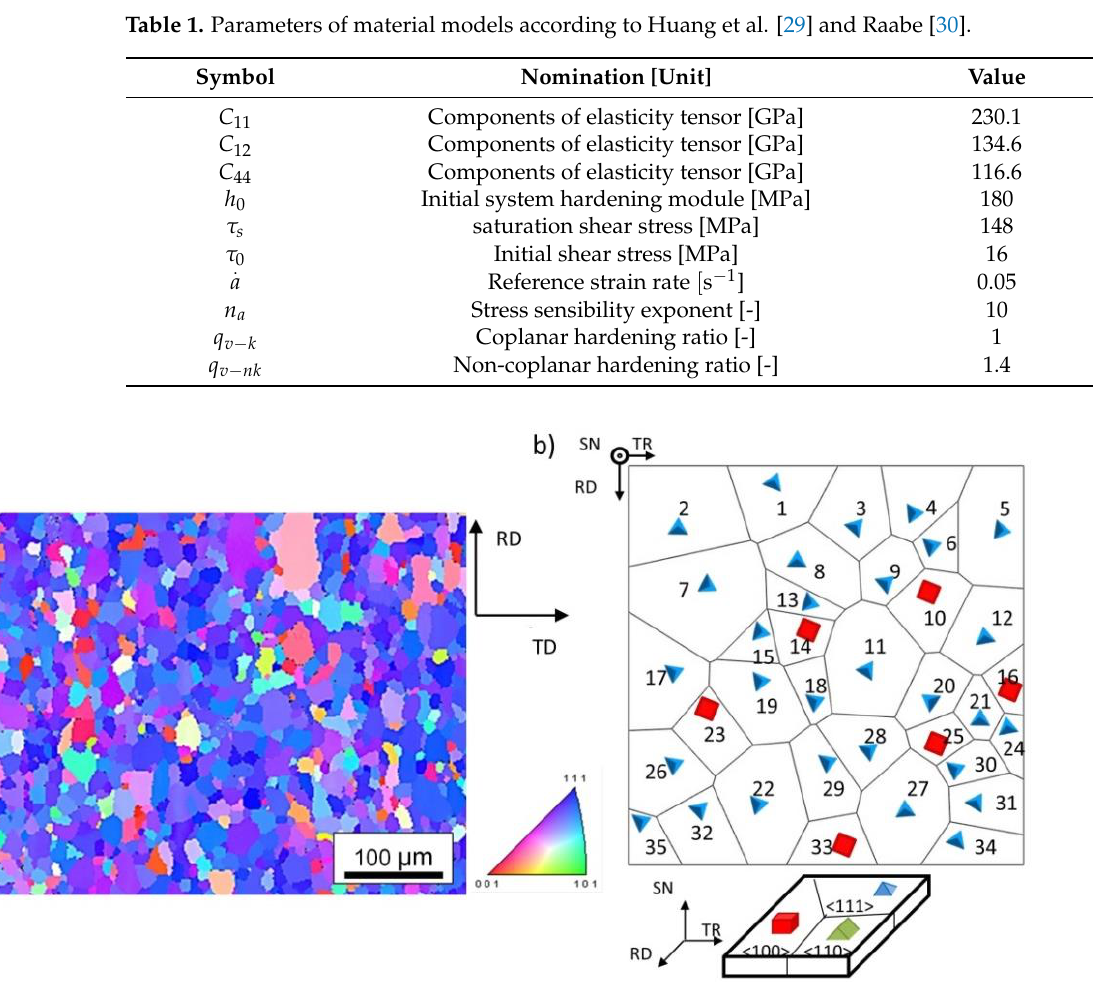
Figure 2. ( a ) Grain structure of polycrystalline material (DX56) with grain orientation determined through electron backscatter diffraction (EBSD); ( b ) specified grain orientation of numerical model in the surface layer with schematic illustration of the orientations with regard to the surface normal (SN) (RD: rolling direction; TD: transverse direction).